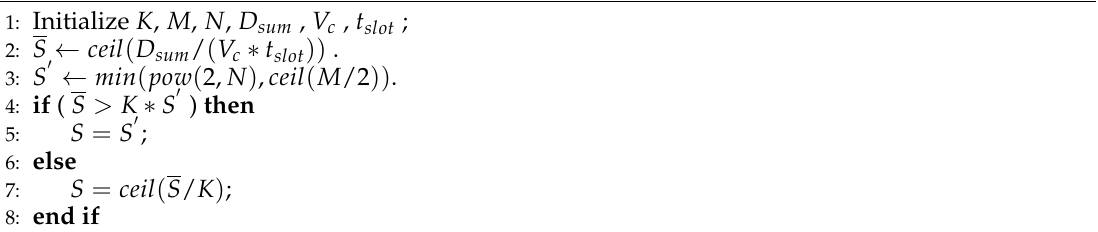
Algorithm 2 The Binary Tree Model Based Adaptive Slot Allocation Mechanism